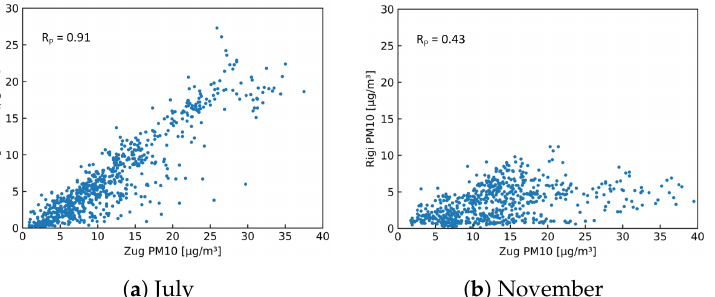
Figure 21. Hourly mean PM 10 data measured at in-luft stations Zug and Rigi. ( a ) N = 740, R P = 0.91; ( b ) N = 665, R P =